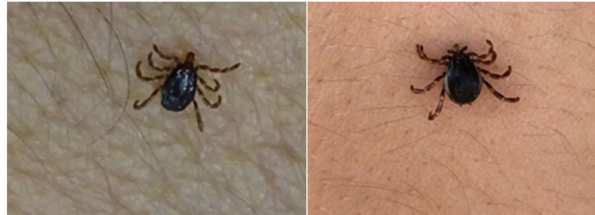
Figure 2. Hyalomma marginatum attempting to attach immediately opening its palps and preparing itself to attach in just a few seconds after climbing on to a human host (left). Hyalomma lusitanicum (right) prefers to avoid this host although it does sometimes prey on humans.